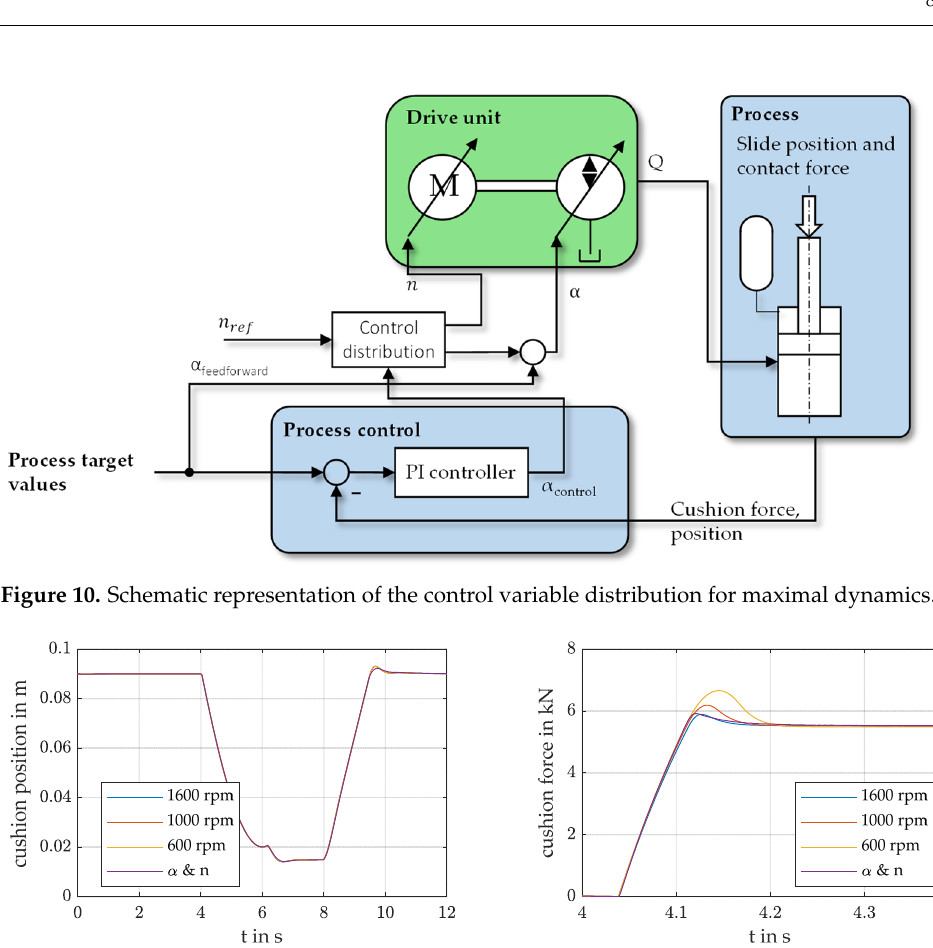
Figure 11. Comparison of the cushion contact force for different constant motor speeds and the combined speed and swash plate angle control, cushion contact force 55 kN.